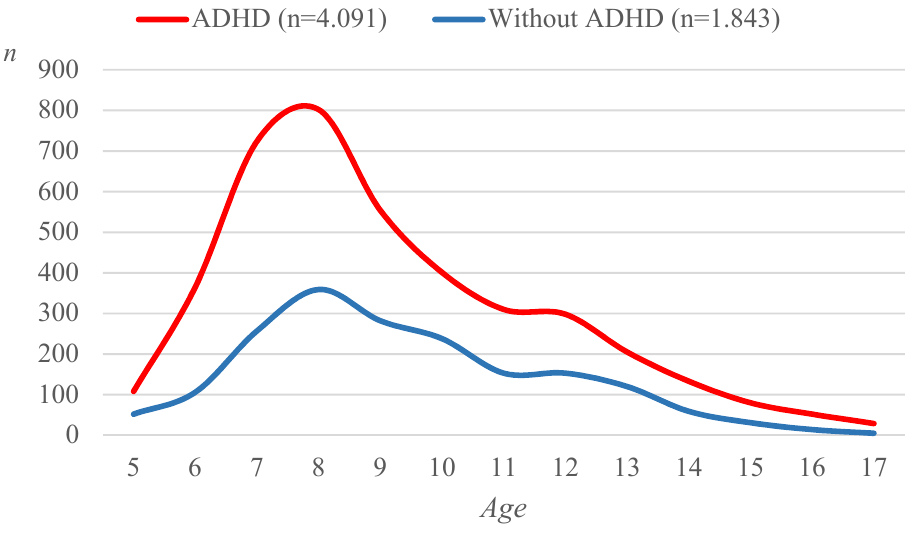
Figure 1. Age of the ADHD patients.